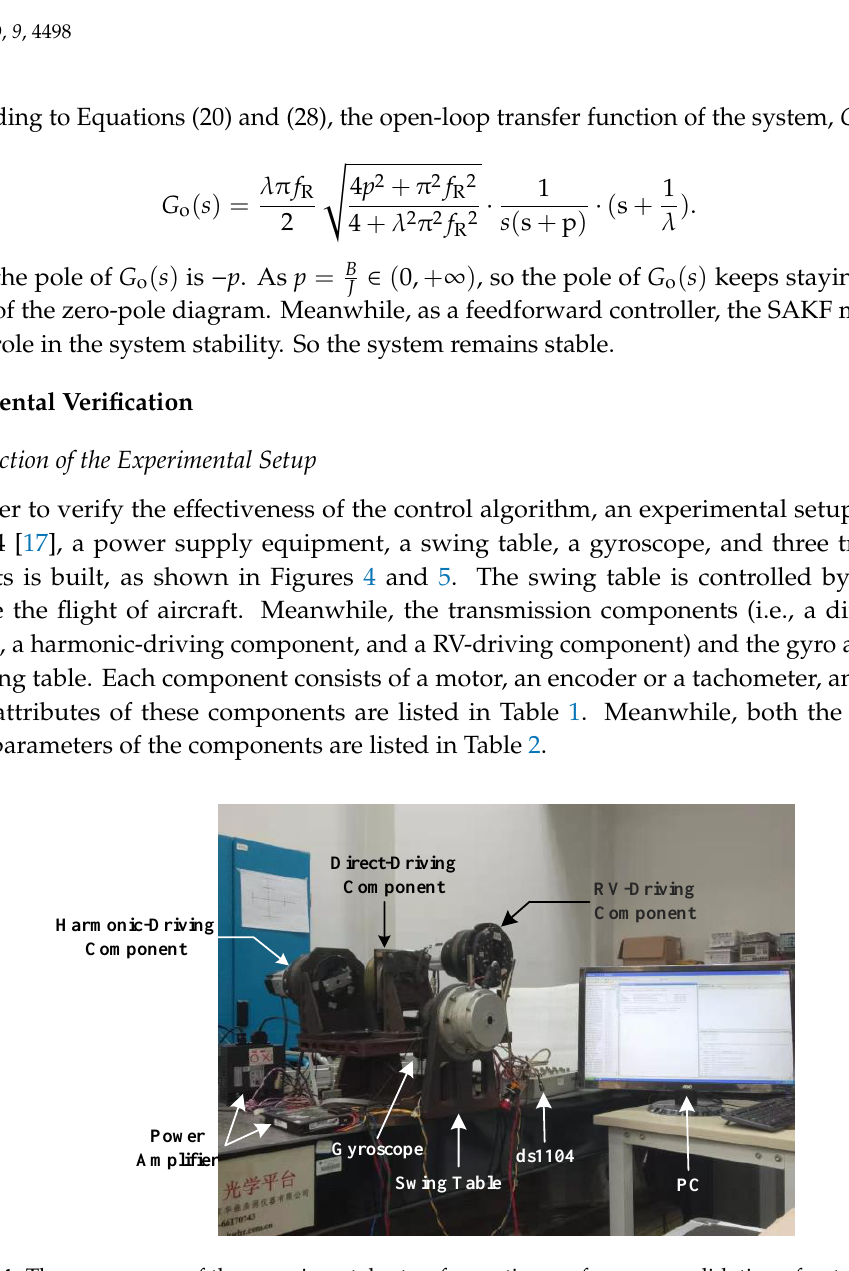
Figure 4. The appearance of the experimental setup for motion performance validation of opto-electric servomechanisms (OESs).